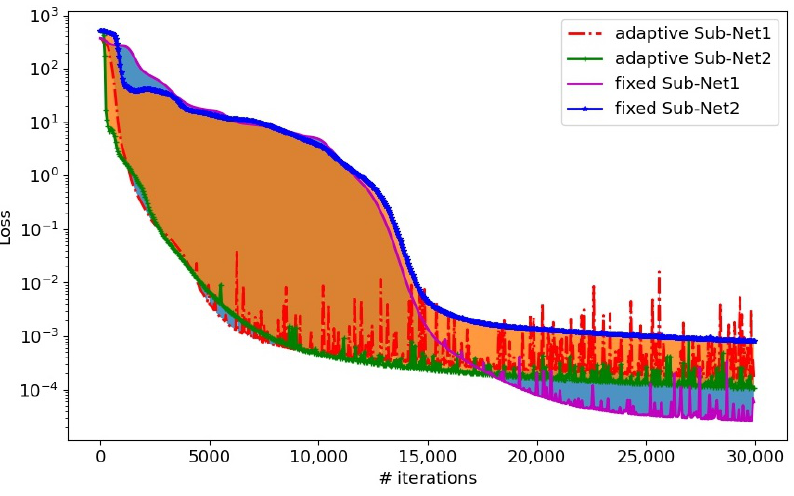
Figure 15. ( a ) The PINN solution and ( b ) the error between PINN and exact solution for Example 5.